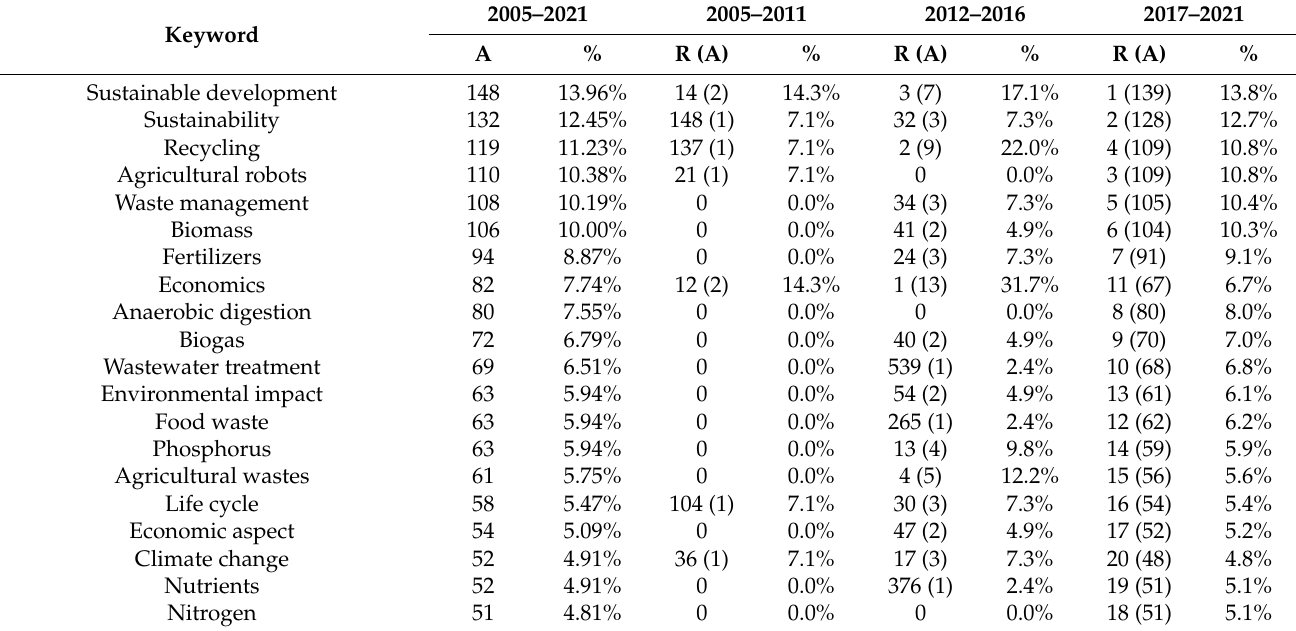
Table 6. Main keywords used in research from 2005 to 2021.